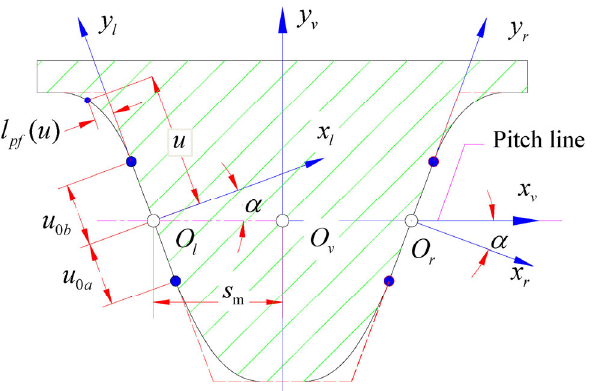
Fig. 1 Modification of tooth profile for the basic